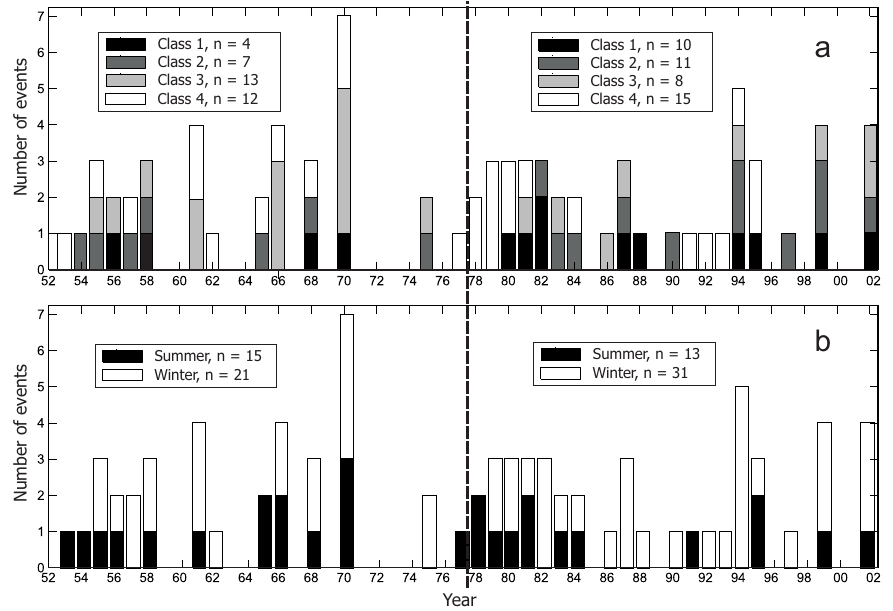
Fig. 9. Time series of trans-basin floods in 1952–2002, stratified into (a) 4 classes of spatial extent and (b) hydrological summer (May– October) and winter (November–April) events. The dashed line indicates the separation into two sub periods (1952–1977; 1978–2002) and the legends reflect the respective numbers of event per period and for either the extent classes (a) or the seasons